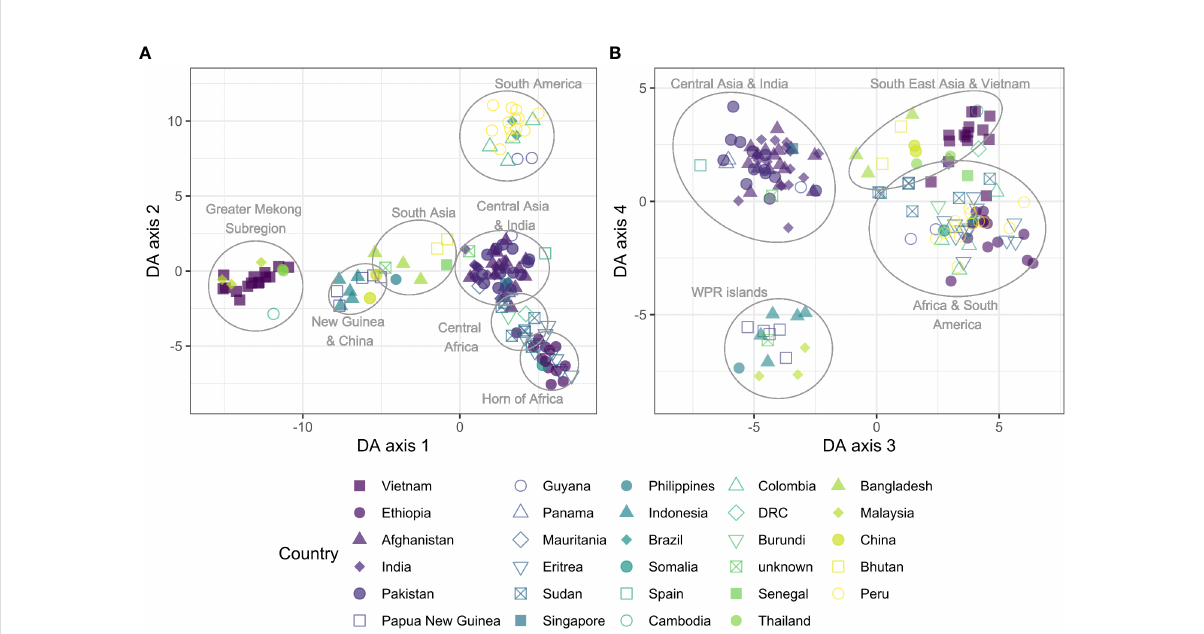
FIGURE 4 Discriminant analysis of principal components (DAPC) of global isolates (n = 148), incl. 15 samples randomly selected from Vietnam. Scatter plot of discriminant analysis (DA) eigenvalues 1 and 2 (A) using all biallelic SNPs detected by the Pv AmpliSeq showed a differentiation from east to west from the Paci fi c into Asia along the x-axis and a separation between Africa and the Americas along the y-axis. Scatter plot of DA eigenvalues 3 and 4 (B) groups African and American samples together, close to South East Asian and Vietnam isolates and separately cluster the WPR islands and Central Asia and India. SNPs contributing most to the DAPC are listed in Supplementary Table 2, Table S5. DAPC was performed with 20 principal components and 20 discriminants as determined through